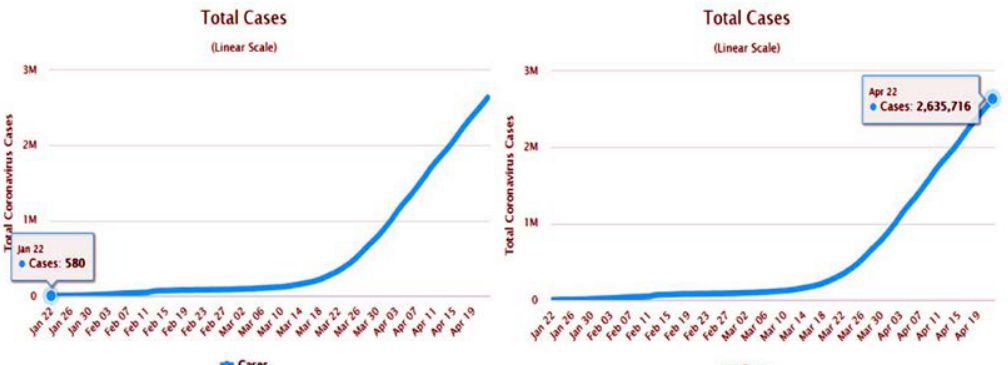
Fig. 3. Number of total cases reported in the starting of year till the date around the globe Source: